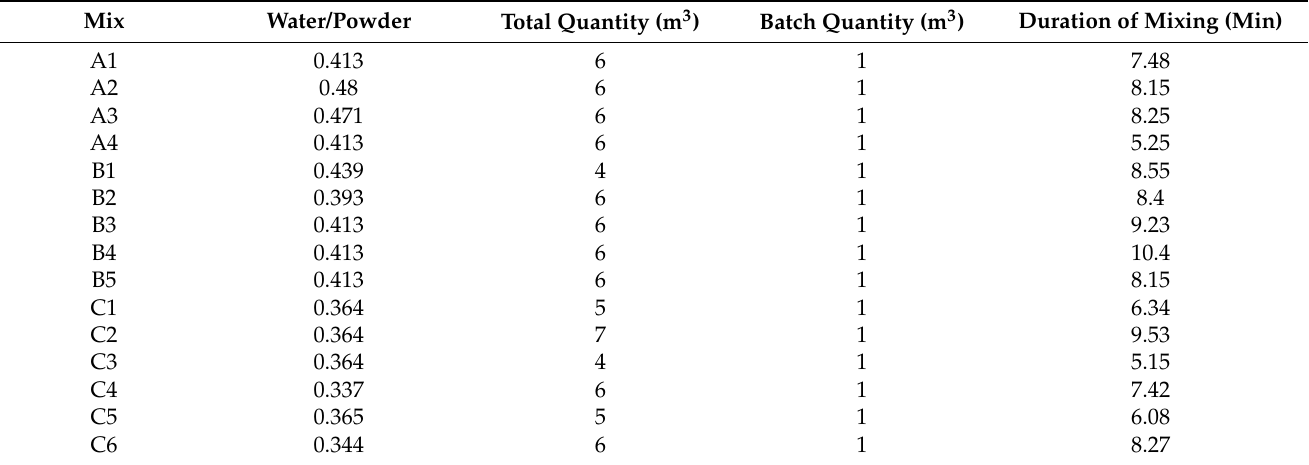
Table 6. Concrete Mix